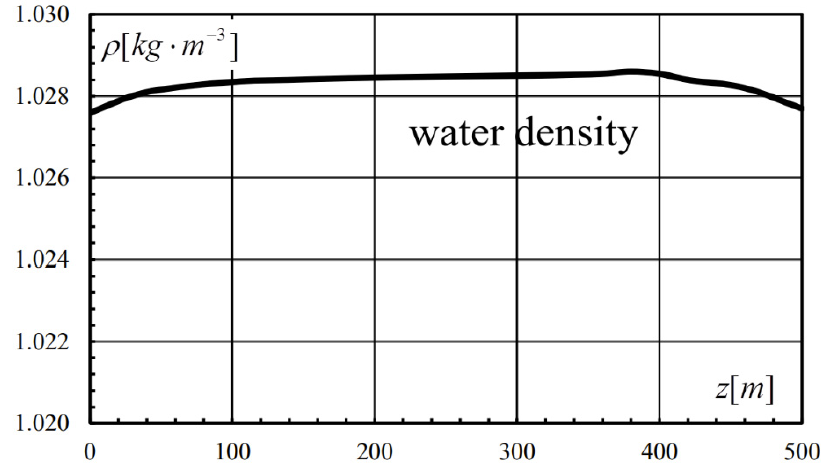
Figure 16. Typical depth-wise density distribution in Northern